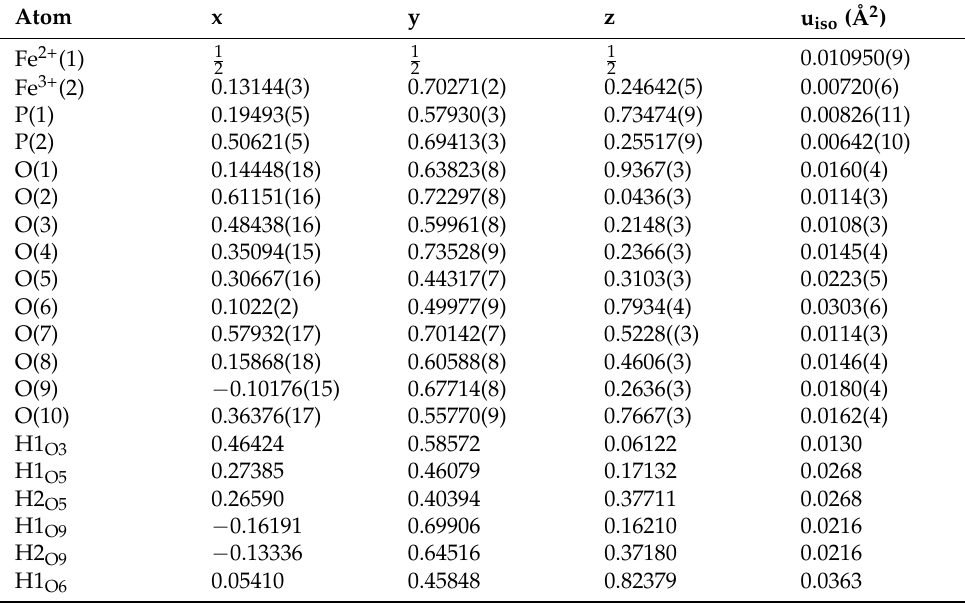
Figure 5. Panel ( a ) shows the specific heat as a function of temperature; the two insets highlight the low temperature region around T N and high temperature region around T S , respectively, where T N and T S are the temperatures where we have the magnetic and structural phase transitions; panel ( b ), shows the magnetic susceptibility versus temperature in zero field cooled (ZFC, red symbols) and field cooled (FC, green symbols) mode (H = 100 Oe); the inset shows the inverse magnetic susceptibility data together with two solid lines representing linear fits of the Curie–Weiss behavior, to low and high temperature regions. Table 1. Data collection statistics at 300 K and 100 K from the P24 and Rigaku Oxford Diffraction instruments; 1st column provides the name of the physical quantities used to described the experi- Table 2. Fractional coordinates at 300 K from laboratory X-rays. H atoms were constrained using a ment and data analysis, 2nd and 3rd columns provide the values to the physical quantities from the riding model with u iso extended by a factor 1.2 of its neighboring non-H P24 instrument, while the 4th and 5th columns list the values from the laboratory instrument.